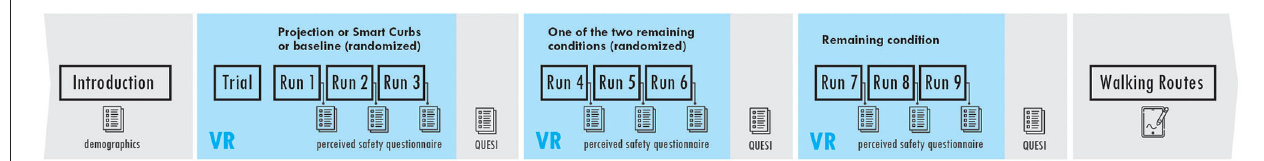
FIGURE 3 | User study procedure. Walking routes were drawn on static images presented on a tablet. The images horizontally present the study procedure in 8 steps including: (1) the introduction (2) trial and first randomized VR run (3) answering of QUESI questionnaire (4) second VR run, depending on order calculated for participant (5) answering of QUESI questionnaire (6) last VR run and (7) answering of QUESI questionnaire (8) drawing of the walking routes. The study procedure is also described in section